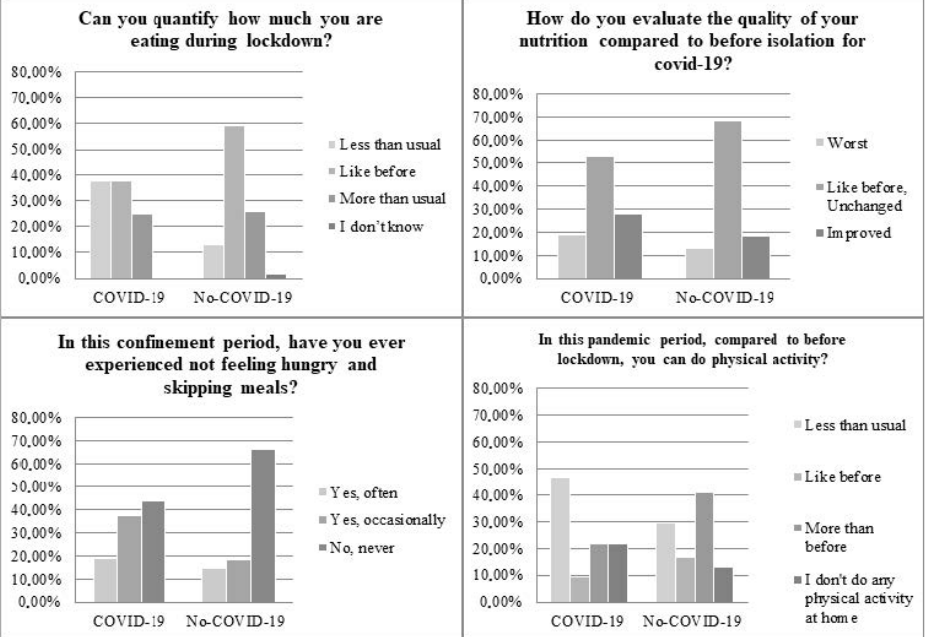
Figure 1. Determinants of the lifestyle changes during COVID-19. Note: A Chi-Square Test was performed to determine whether the proportions were equal between COVID-19 and Non-COVID-19. The proportions only differed significantly in the quantity of eating, X 2 (3, n = 60) = 7934, p = 0.047. Table 3. Correlations between AEBQ and EuroQoL scores during lockdown.